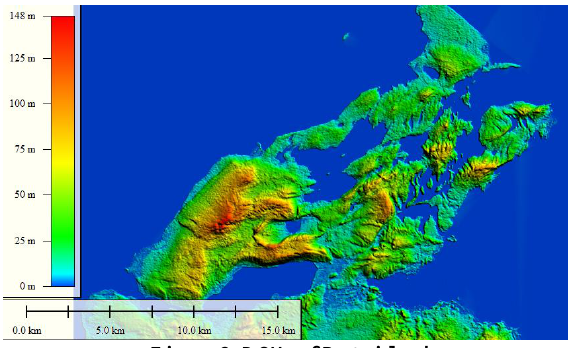
Figure 2. DSM of Rote islands